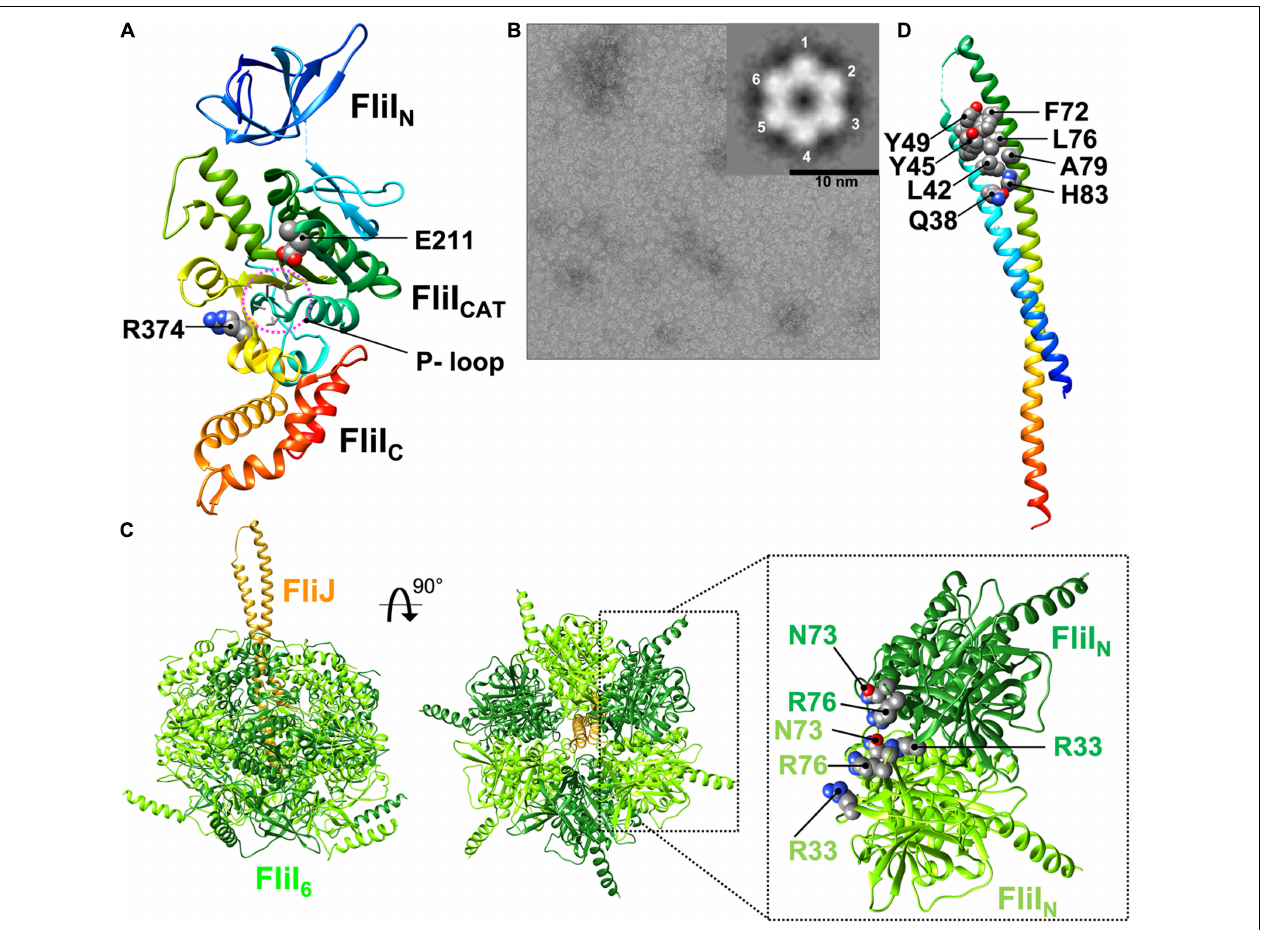
FIGURE 5 | Atomic model of the FliI 6 -FliJ 1 ATPase ring complex. (A) C α ribbon representation of FliI (PDB ID: 5B0O). FliI consists of an N-terminal (FliI N ), an ATPase (FliI CAT ), and a C-terminal (FliI C ) domain. FliI N is involved in formation of the FliI 6 ring. FliI CAT contains the highly conserved P-loop, the catalytic glutamate (E211), and an arginine finger (R374), which are all involved in ATP hydrolysis. The ATP catalytic cycle induces sequential and cooperative conformational changes of FliI C , which interacts with FliJ. (B) Electron micrograph of negatively stained FliI ring-like structures in complex with Mg 2 + -ADP-AlF 4 . The inset shows a 2D class average of the FliI ring structure. (C) Model of the FliI 6 -FliJ 1 ring model. R33, N73, and R76 of FliI N regulate FliI ring formation. FliJ binds to the center of the FliI 6 ring. (D) C α ribbon representation of FliJ (PDB ID: 3AJW). FliJ forms a two stranded coiled-coil structure. The highly conserved Q38, L42, Y45, Y49, F72, L76, A79 and H83 residues of FliJ extends out of the FliI 6 ring and are interact with FlhA L